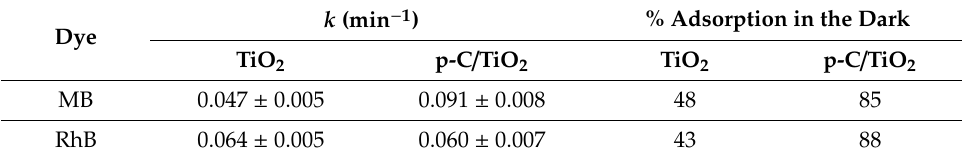
Table 1. Degree of adsorption and first-order kinetics of photodegradation of dyes MB and RhB having a concentration of 1.0 μ M on pristine TiO 2 and on p-C/TiO 2 in aqueous media under ambient conditions by UV irradiation at 366 nm.